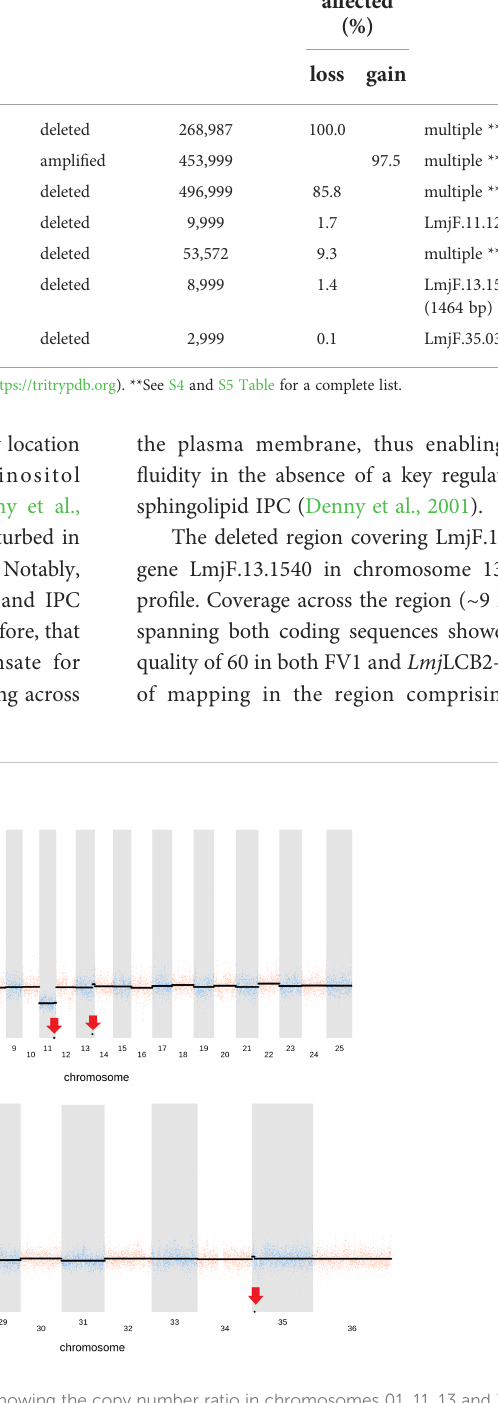
TABLE 4 Ploidy in Lmj LCB2-/- of Leishmania major . Contig Chr size Chr coordi- log2 copy ratio to WT (bp) * nates